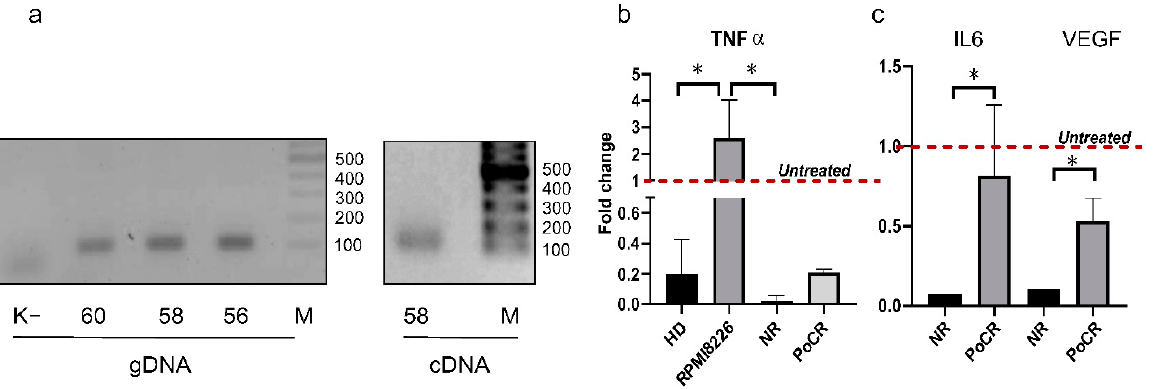
Figure 7. Influence of proinflammation cytokines (TNF α and IL-6) and VEGF on HS2/HS3 transcrip- tion. ( a ) Primers verification by PCR on genomic DNA (gDNA) and cDNA. MW marker is shown on the right sides of the gels, temperatures of annealing are shown below the images; ( b ) qPCR of HS2/HS3 transcripts in cells treated with TNF α , in each group transcription in untreated cells was set as 1 (red dashed line); ( c ) qPCR of HS2/HS3 transcripts in cells treated with IL-6 or VEGF, in each group transcription in untreated cells was set as 1 (red dashed line). * p < 0.05.